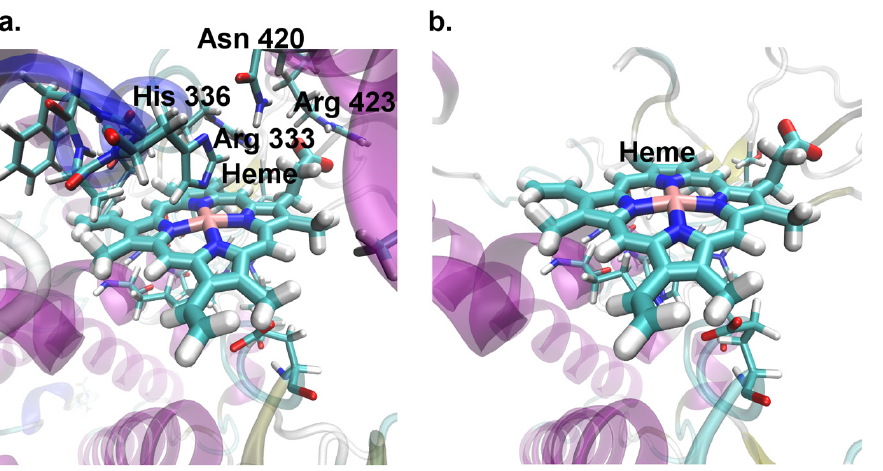
Figure 4. Three-dimensional model structure of the Drosophila phenoxazinone synthase (PHS) active site. ( a ). CS ; ( b ). cd 1 (amplicon III).